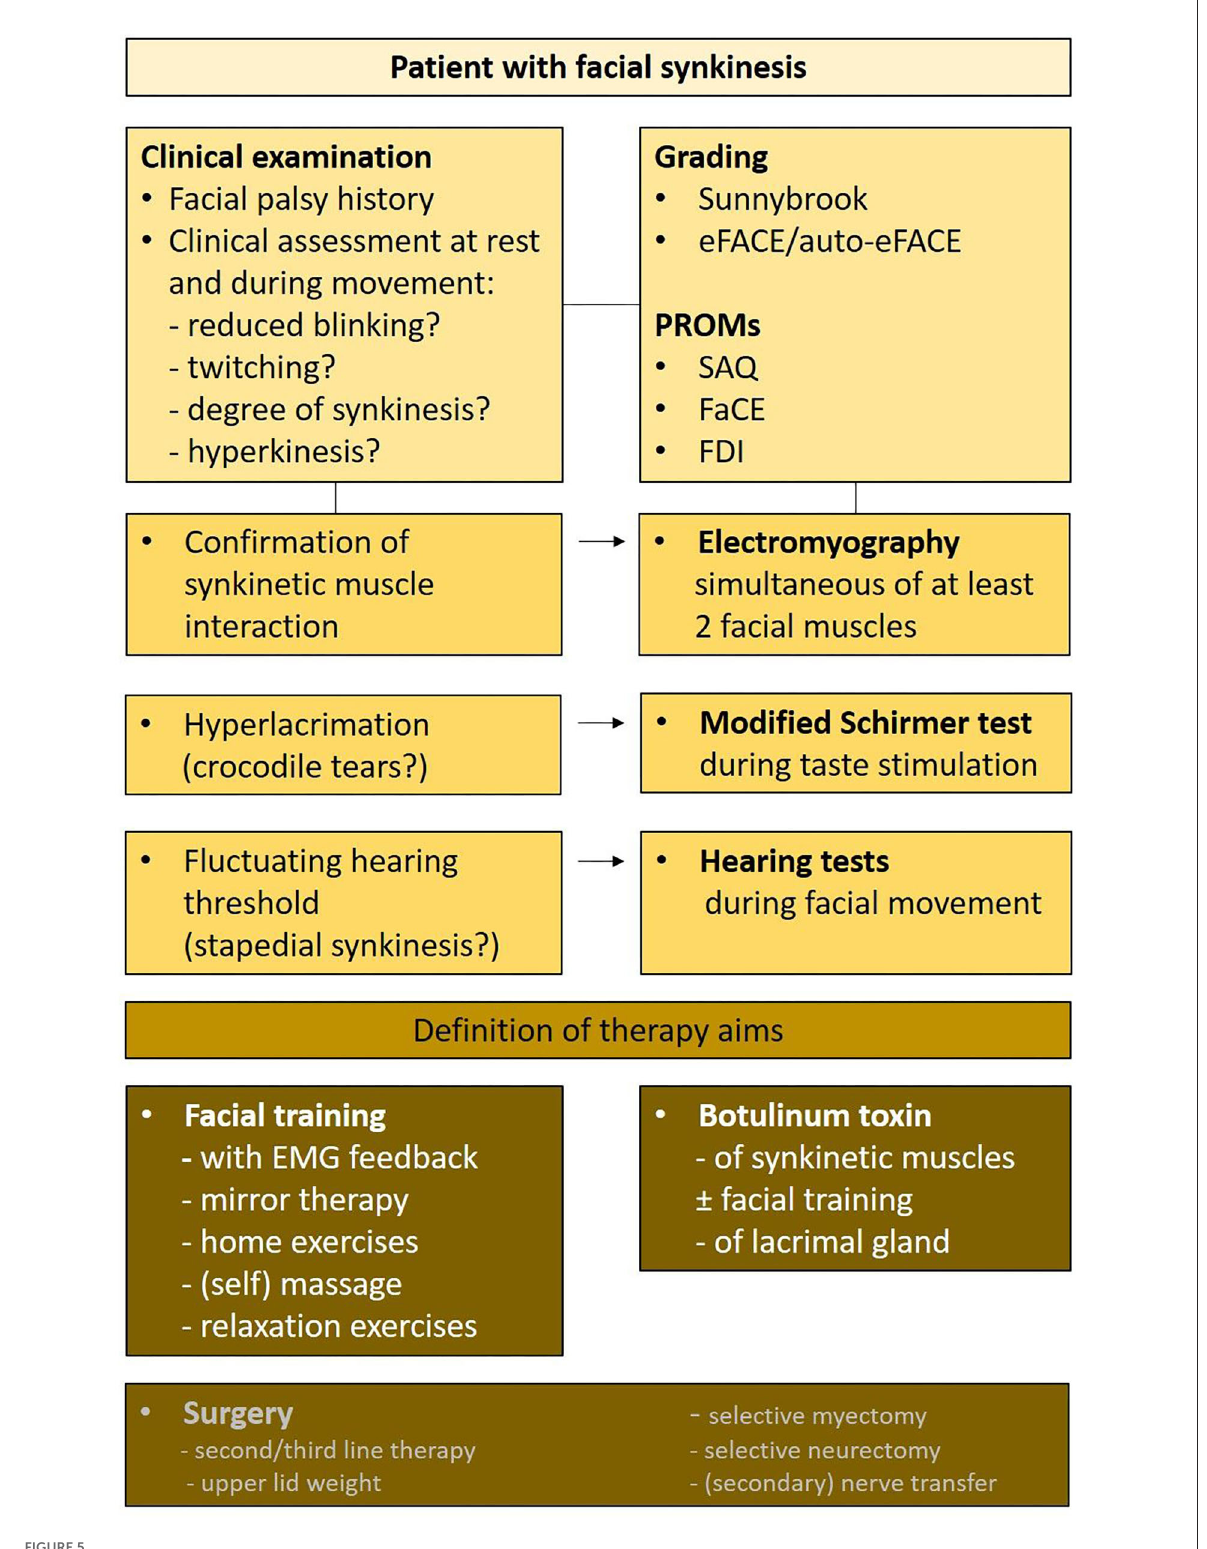
FIGURE5 Therapy algorithm of all important diagnostics to define personalized therapy aims allowing to define the therapy strategy. PROM, patient-reported outcome measures; SAQ, Synkinesis Assessment Questionnaire; FaCE, Facial Clinimetric Evaluation; FDI, Facial Disability